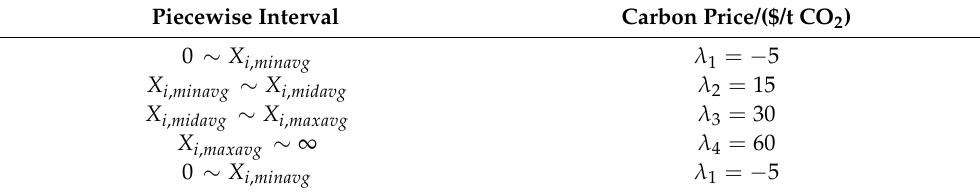
Figure 5. The modified IEEE 39-bus power system and the Belgian 20-node gas system. Table 1. Parameters o f the thermal power units. Table 4. Parameters of the ladder-type carbon price.